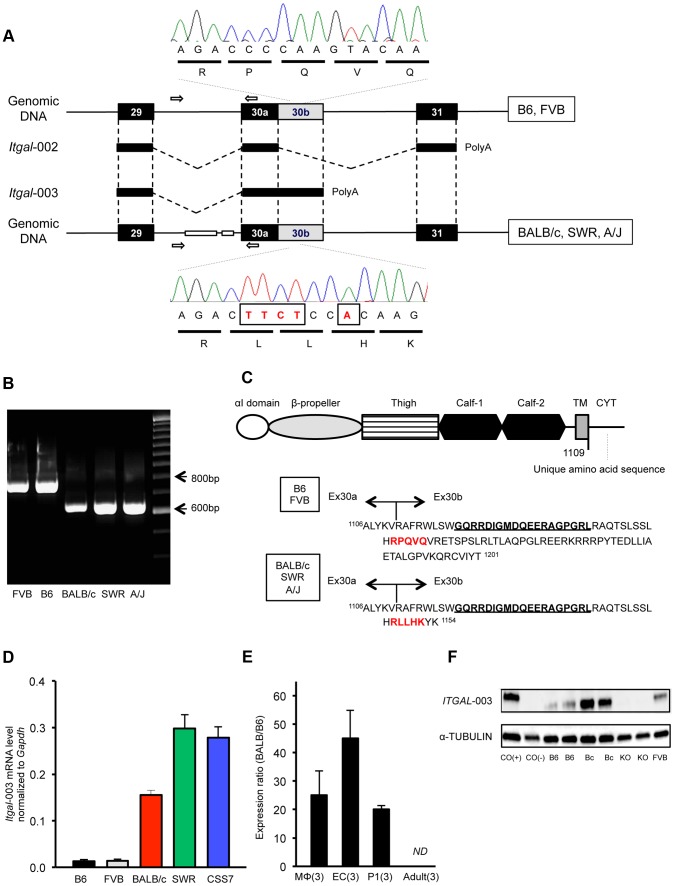
A truncated cytoplasmic tail of the protein and increased mRNA level of a splice variant of Itgal correspond with allelic variation between mouse strains.A. Schematic of the Itgal-003 transcript showing sites of the ∼150-bp deletion in intron 29 and a 5-bp insertion (TTCT and A) in the coding region of exon 30b, present in BALB/c, SWR, and A/J strains. The 5-bp insertion causes a premature termination of the protein, resulting in a shorter cytoplasmic tail of the protein. B. Allelic variation of the ∼150 bp deletion in intron 29 in 5 mapping strains is confirmed by PCR of genomic DNA, with primer pairs (white arrow in A). C. Amino acid sequences of the cytoplasmic tail of the Itgal-003 protein. The 5-bp insertion in exon 30b results in an Itgal-003 protein that is identical to the canonical protein, except a short stretch of new amino acid sequence in the truncated cytoplasmic tail. The 5-amino acid sequence in red is matched with the electropherograms in (A). The 19 amino acids (GQRRDIGMDQEERGPGRL) bolded and underlined are used as an epitope to generate an Itgal-003-specific polyclonal antibody. D. mRNA levels of Itgal-003 transcripts (ENSMUST00000120857) in P1 cortex from B6, FVB, BALB/c, SWR/J, and CSS7 strains as determined by qRT-PCR. Each bar represents mean ± SEM. E. The allele-specific expression ratio of Itgal-003 in F1 mice. The level of BALB/c-specific Itgal-003 transcript was approximately 26 times, 44 times, and 19 times higher than the B6-specific transcript in macrophages (MΦ), endothelial cells (EC) and P1 cortex, respectively. Itgla-003 was not detected in adult cortex (ND). Each bar represents the allele-specific expression ratio (BALB/B6) of the Itgal transcript averaged for three F1 animals. F. Western blot for an epitope specific to the Itgal-003 encoded protein. Lysates of P1 brain of B6, BALB/c, Itgal knockout (KO) and FVB mice. Cos (+), the recombinant Itgal protein generated by transfection of COS-7 cells with Itgal-003 cDNA and Cos (−), MOCK transfected COS-7 cells with pEYFP plasmid.